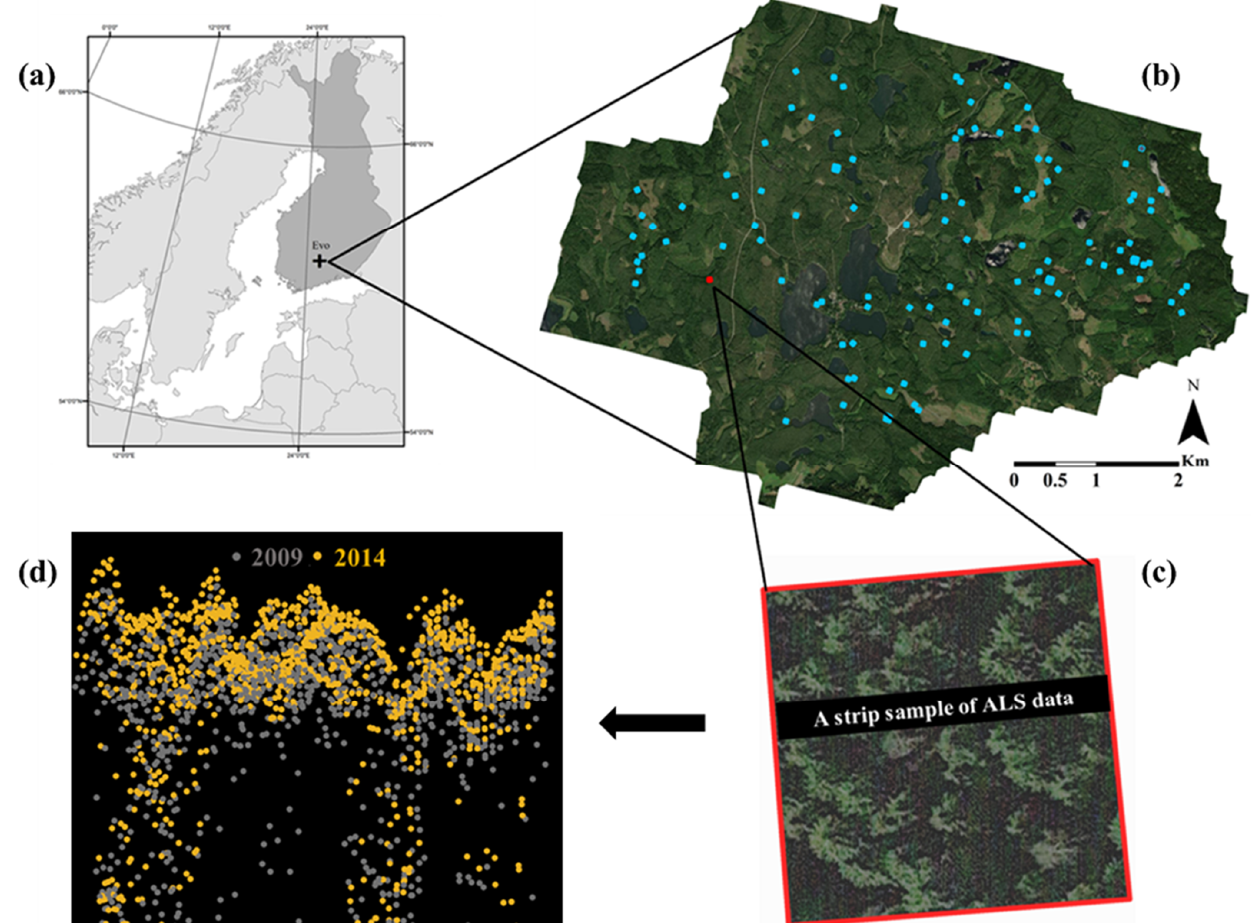
Figure 1. ( a ) Study area in Evo, Finland, and ( b ) distribution of the field plots. ( c ) A strip sample of a plot showing the bi-temporal ALS data acquired in 2009 (gray) and 2014 (yellow) ( d ).